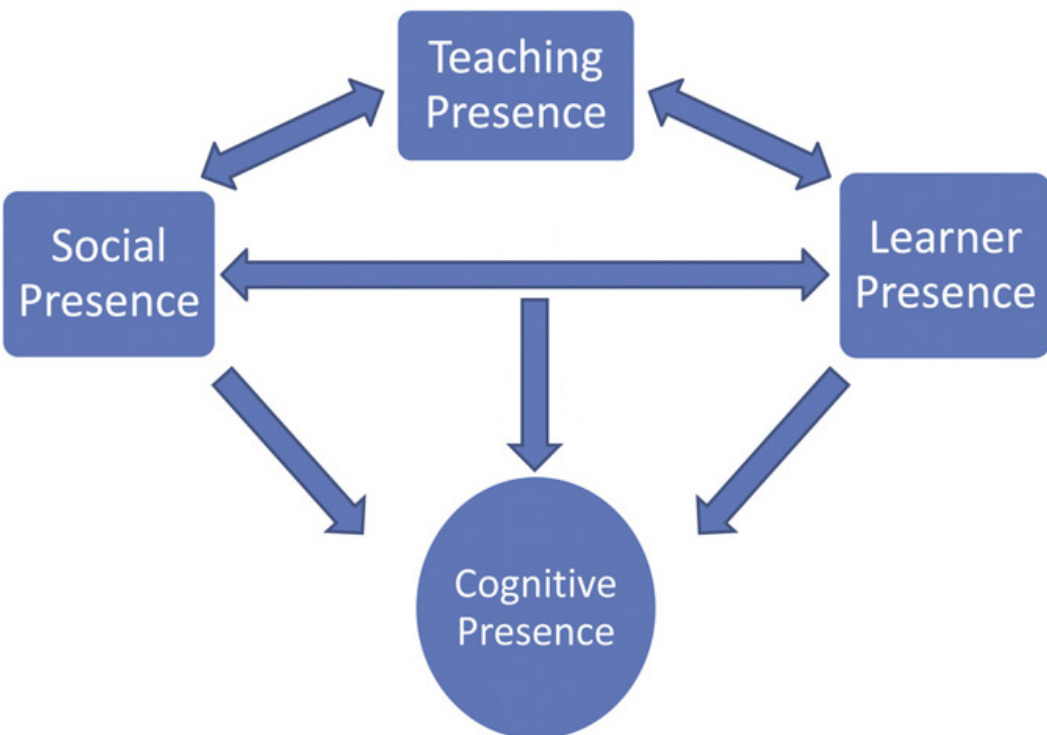
Figure 3 . Revised community of inquiry model, including “learner presence” (Shea & Bi - djerano,